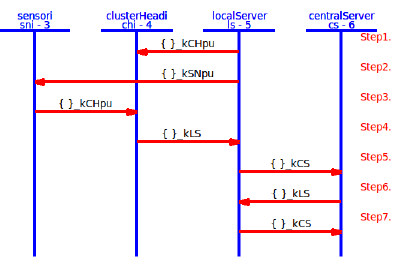
Figure 9. REISCH’s